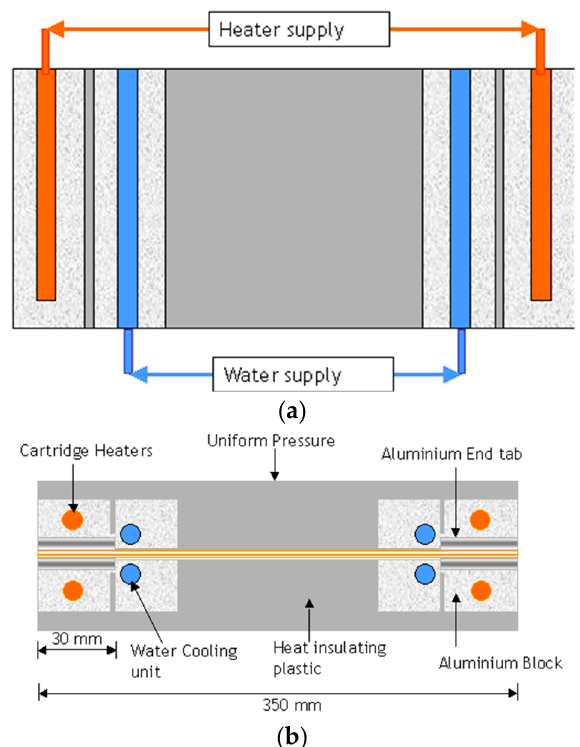
Figure 11. ( a ) Plan-view of the cartridge-based heating of the end-tabbed region and the water-based cooling of the preform in the vicinity of the heated region; ( b ) Side-view of the heating/cooling systems used in the production of the end-tabbed preform.